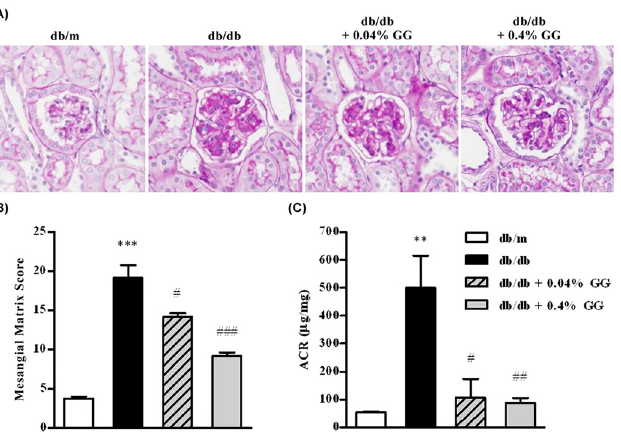
Fig 5. The effects of gemigliptin on mesangial matrix expansion and urinary albumin/creatinine ratios in db/db mice. Mesangial expansion was explored by PAS staining of the kidneys of a) db/m, b) db/db, c) db/ db + 0.04% (w/w) gemigliptin-, and d) db/db + 0.04% (w/w) gemigliptin-treated mice (A). Quantitative analysis of glomerular matrix scores (B). Urinary albumin/creatinine ratios (C). The results are expressed as means ± SEMs. ** p < 0.01, *** p < 0.001 vs. db/m; #p < 0.05, ##p < 0.01, ###p < 0.001 vs. db/db. Original magnification ×400.